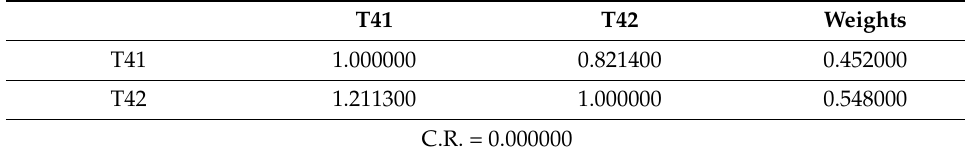
Table 11. Aggregated pair-wise comparison matrix at level 2 for Attack Origin.